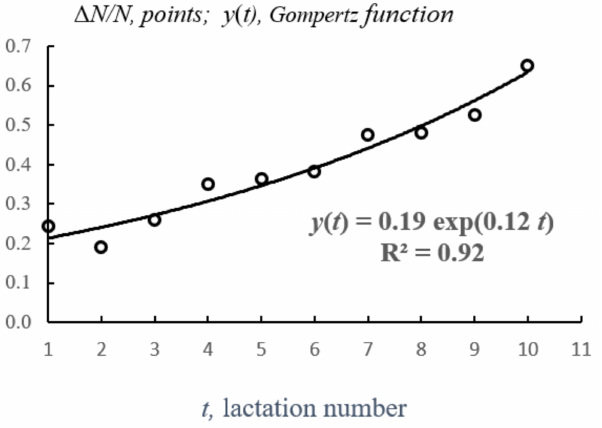
Figure 1. Empirical trend of the age-related increase in the disposal rate of the cows ( ∆ N / N ) and the approximating Gompertz function y ( t ); t is lactation number.